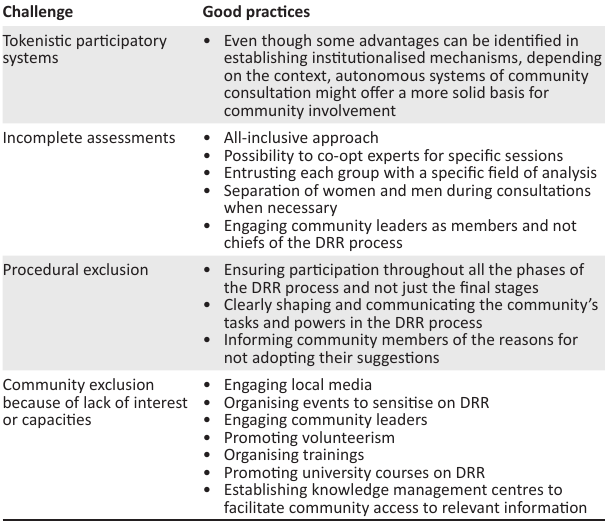
TABLE 3: Important factors in the effectiveness of community participation. TABLE 2: Institutional development characteristics mainstream and integrate